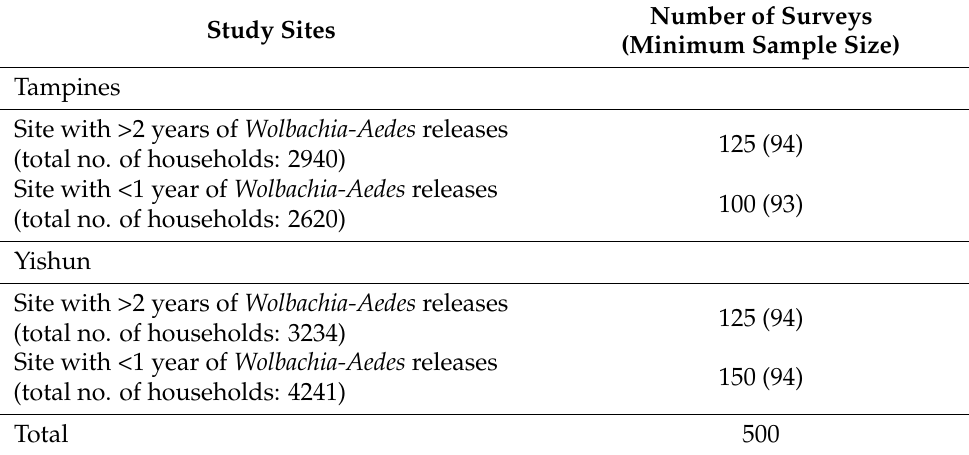
Table 1. A total of 500 household surveys were conducted at Tampines and Yishun study